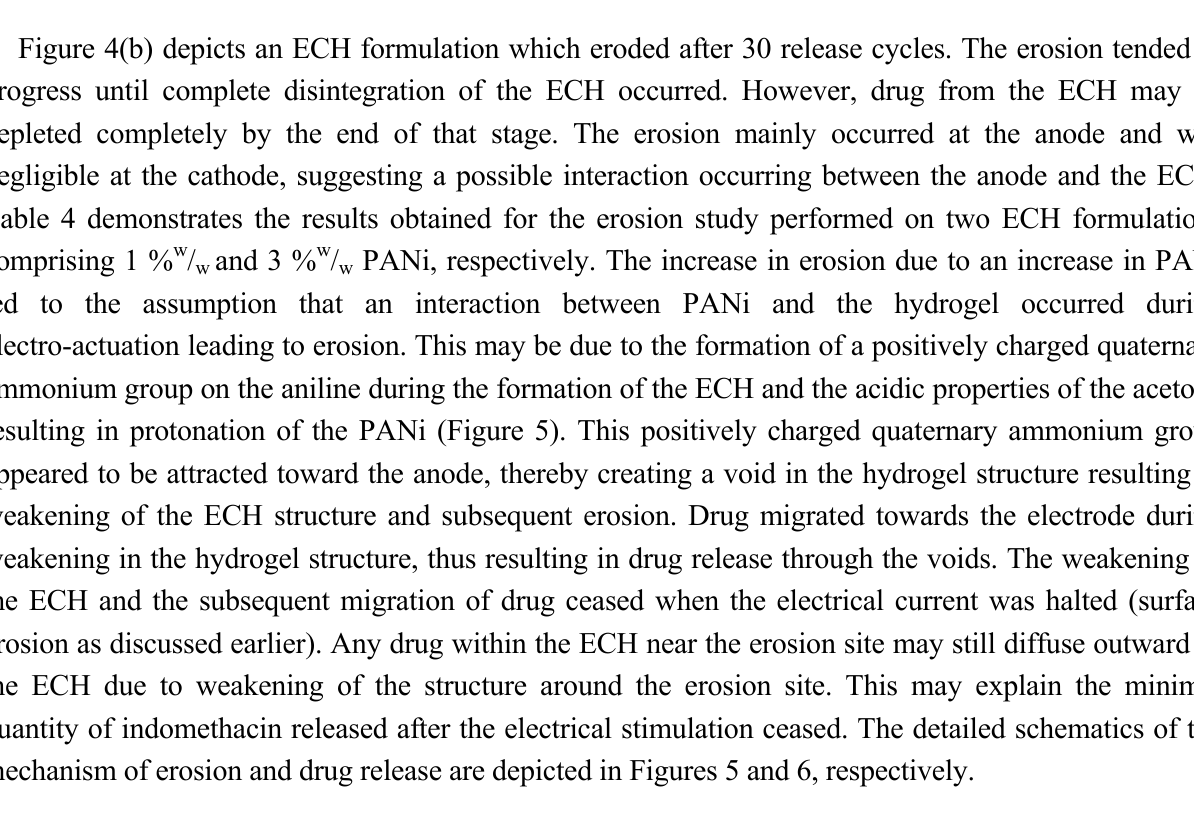
Table 4. Erosion rate data of ECH containing varying concentrations of